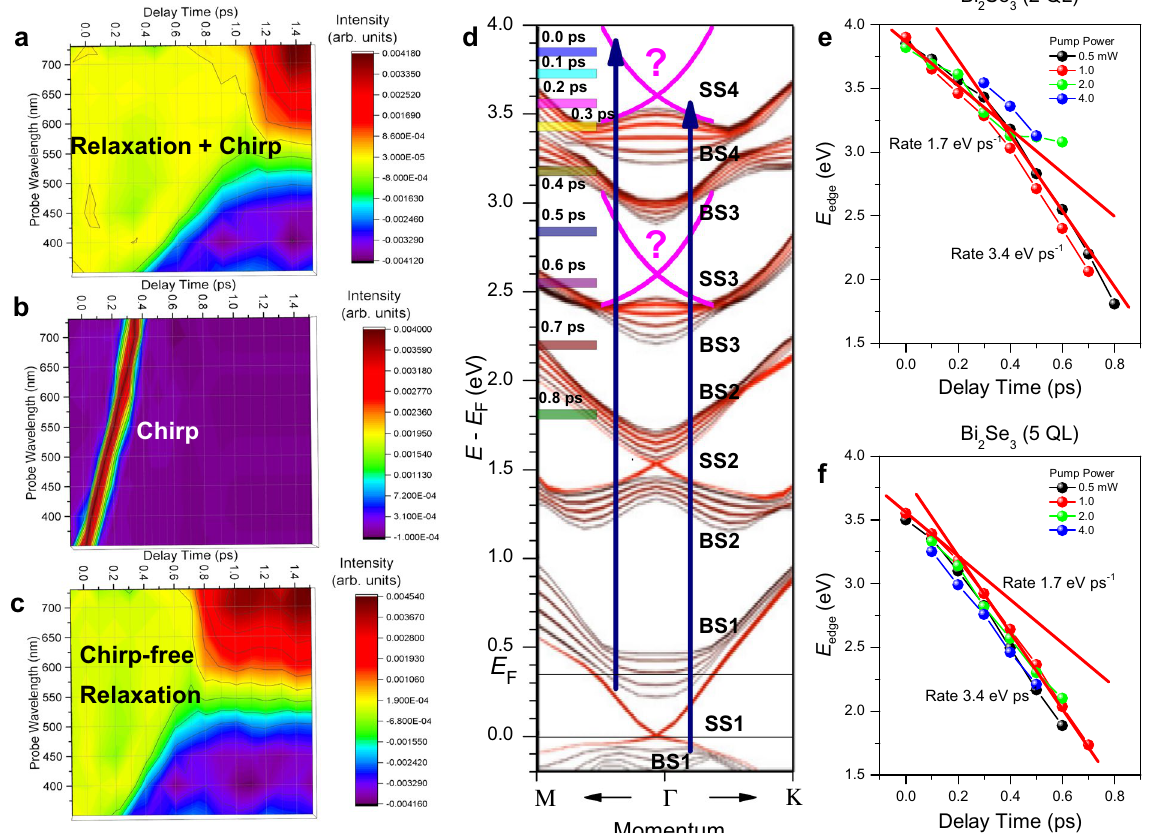
Figure 3. Chirp correction, pumping regimes, and electron energy loss rates for the topologically trivial insulator phase and the gapped topologically nontrivial insulator phases of the 2D TI Bi 2 Se 3 . ( a – c